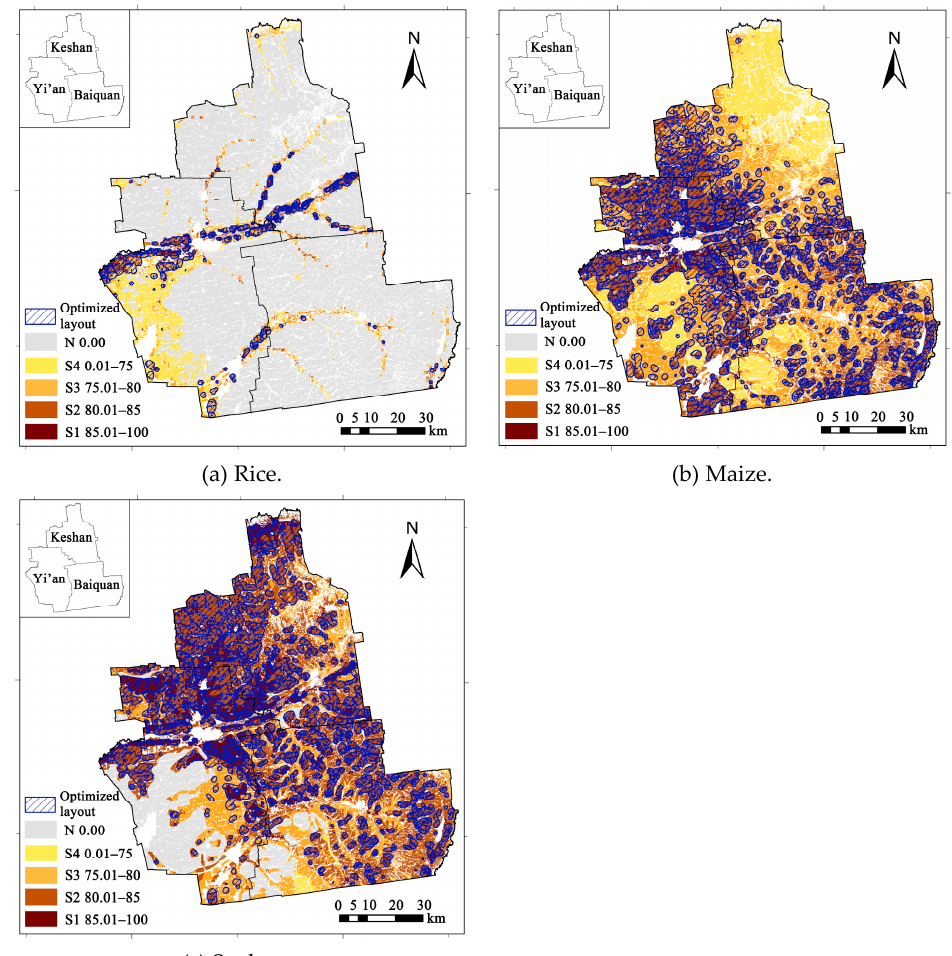
Figure 4. Optimized layout of rice ( a ), maize ( b ), and soybean ( c ) in the study